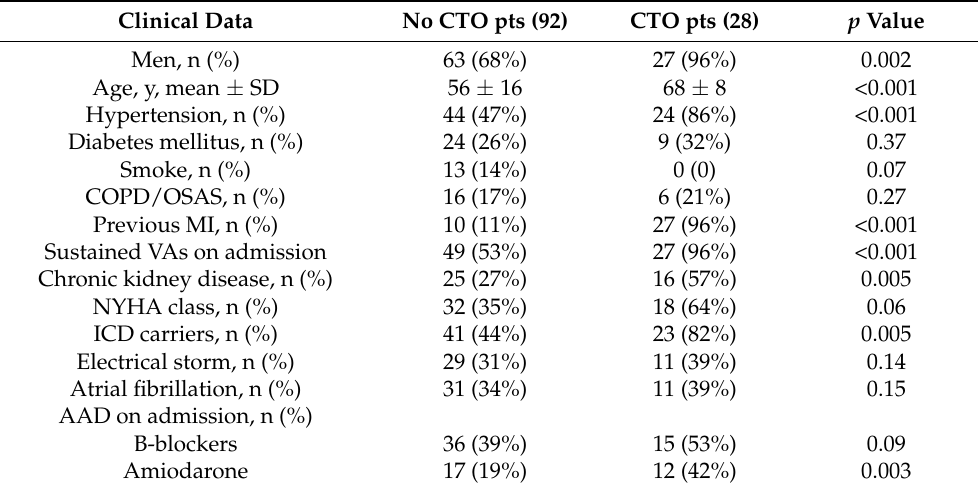
Table legend: CTO: Coronary total occlusion; COPD: chronic obstructive pulmonary disease; OSAS: Obstructive Sleep Apnea Syndrome; MI: myocardial infarction; VAs: ventricular arrhythmias; ICD: implantable cardioverter defibrillator; AAD: anti-arrhythmic drugs.